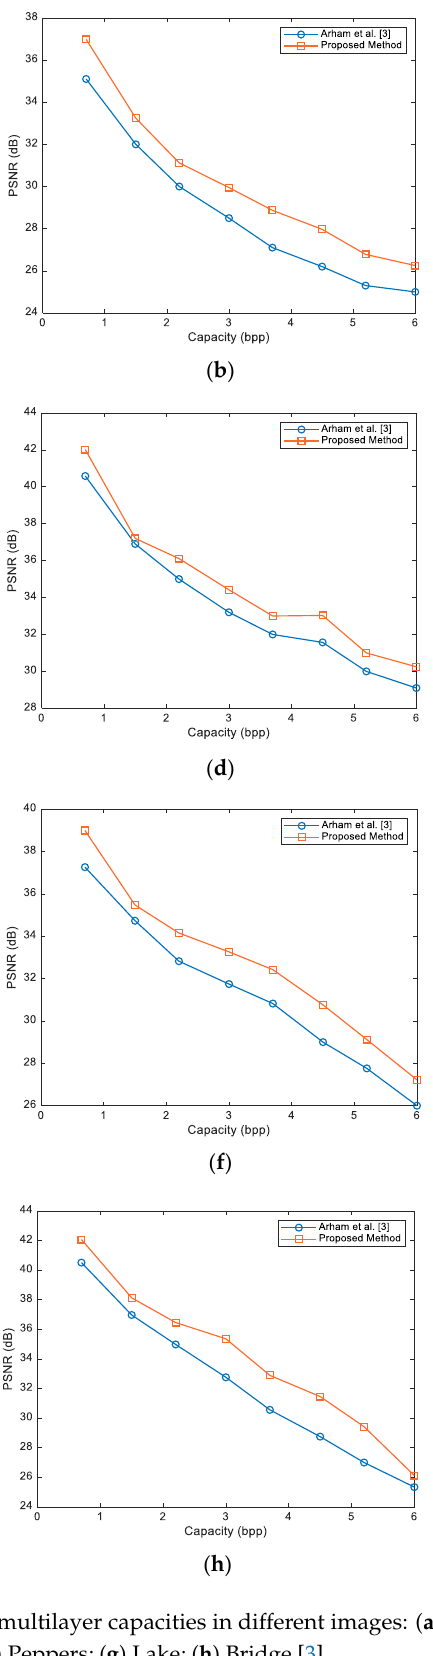
Table 6. Comparison of the SSIM in common images for different capacities. Proposed